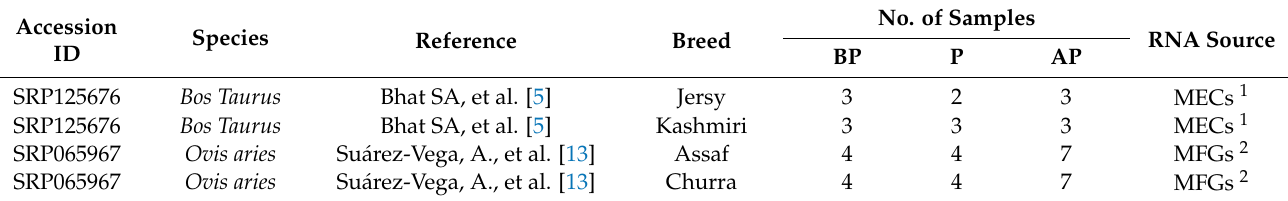
Table 1. Dataset ID, species, and the number of specimens chosen for variant